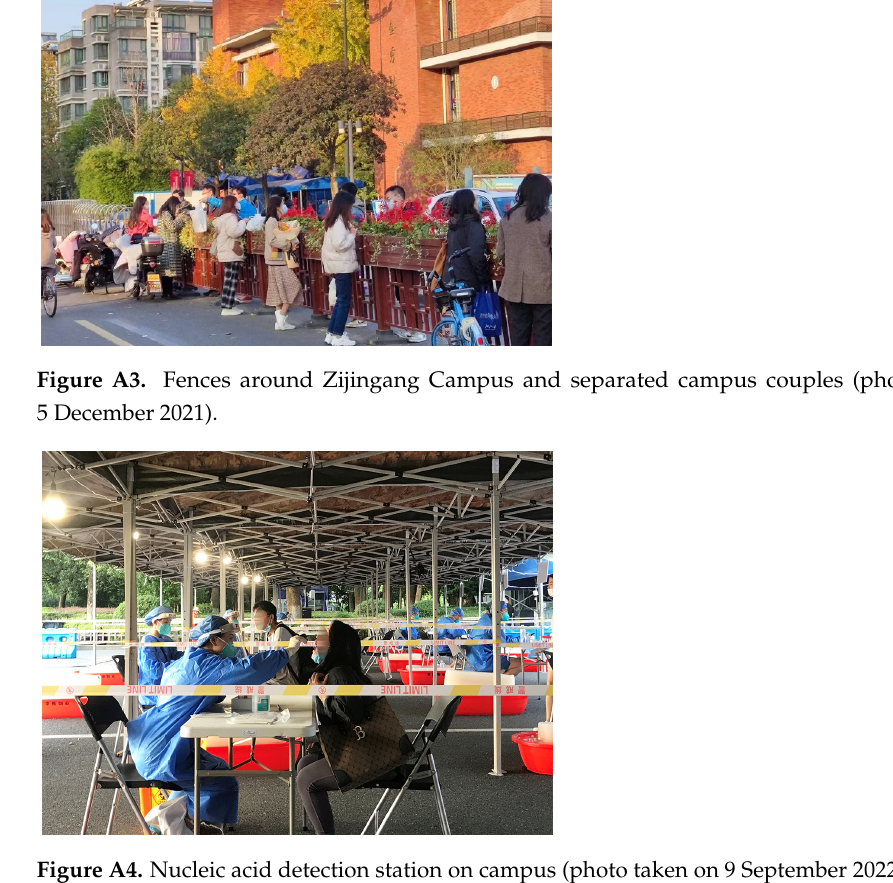
Figure A4. Nucleic acid detection station on campus (photo taken on 9 September 2022).